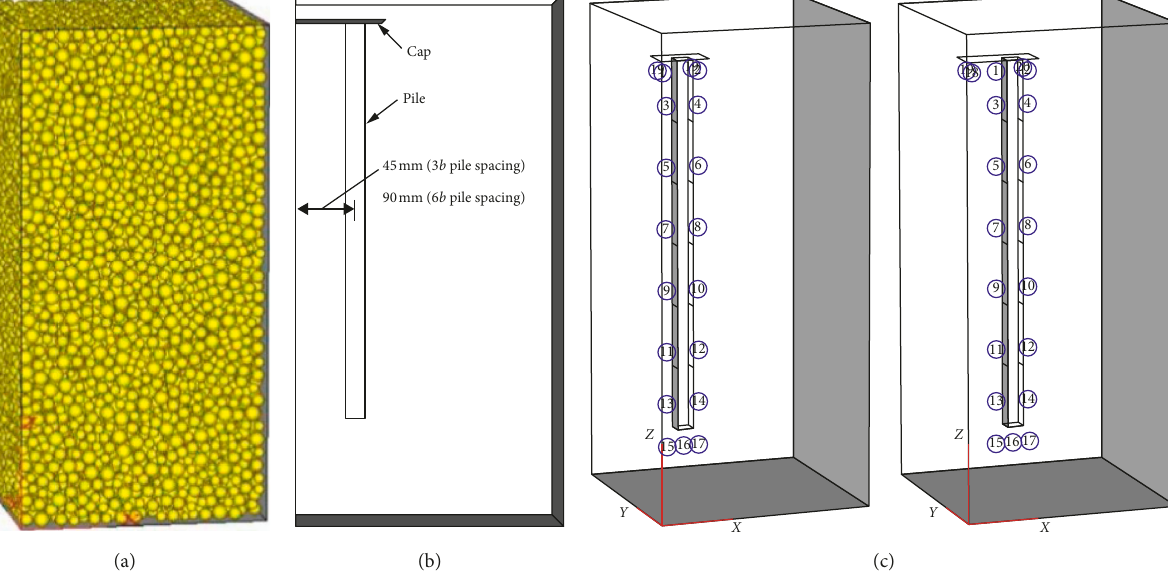
Figure 12: PFC3D model of the pile group and the layout of measurement spheres. (a) Sand model. (b) Distance between the pile to wall. (c) Measurement spheres.